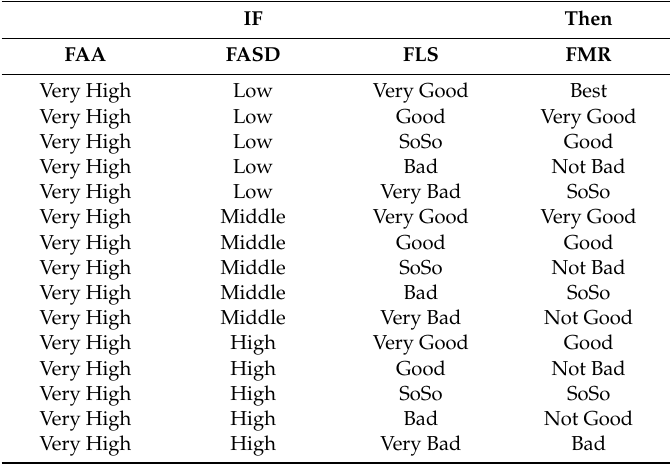
Table 3. Stage 1 rules: Some part of Flexion motion’s rules. IF